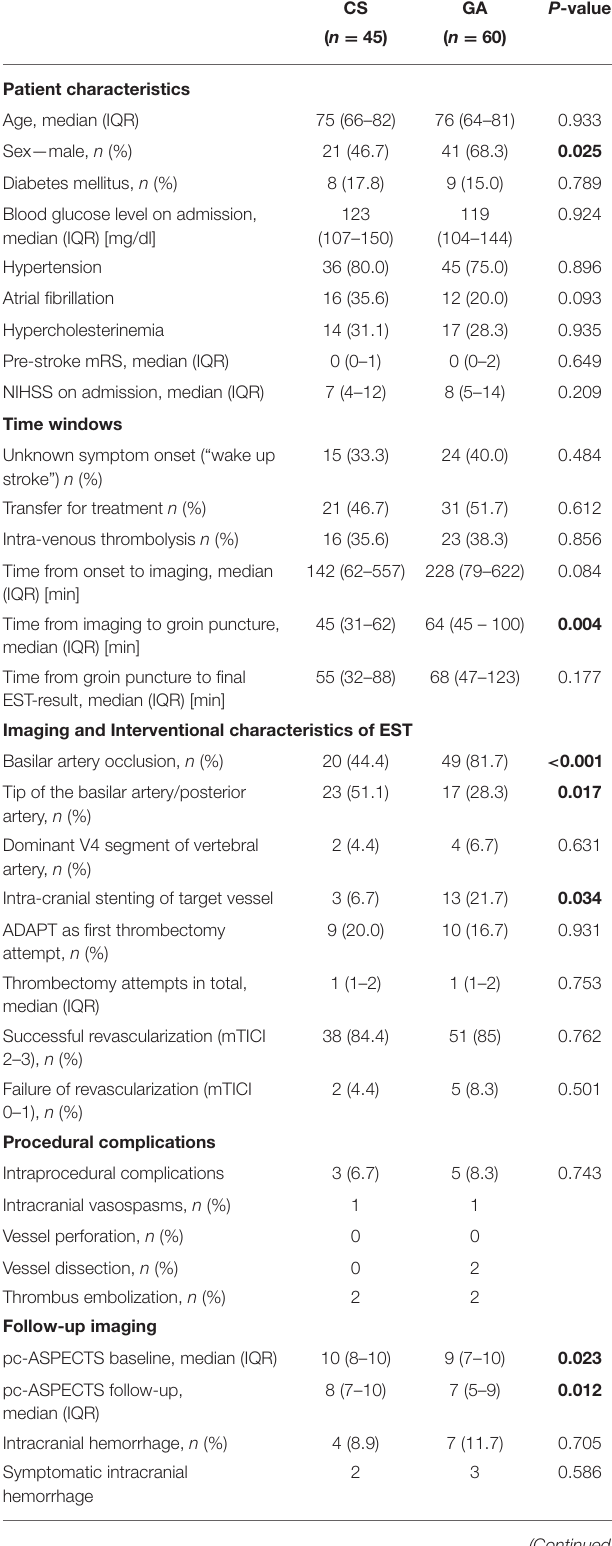
TABLE 1 | Group comparison of patients treated for LVO of the posterior circulation with EST under conscious sedation (CS) or general anesthesia (GA).